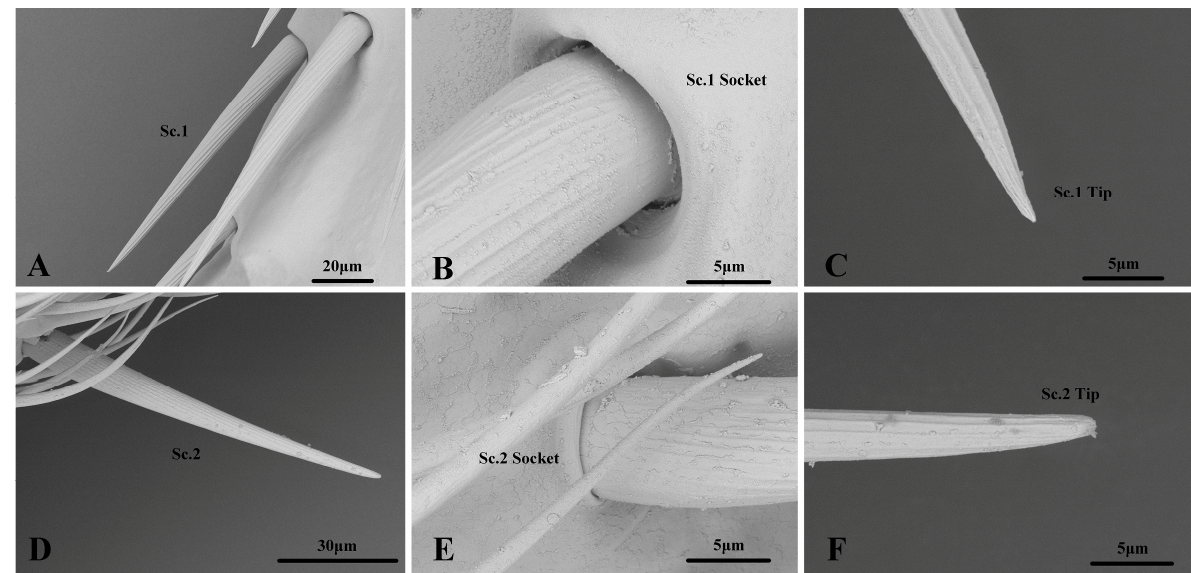
Figure 7. ( A – F ). Sensilla Chaetica of N. meleagris antennae.